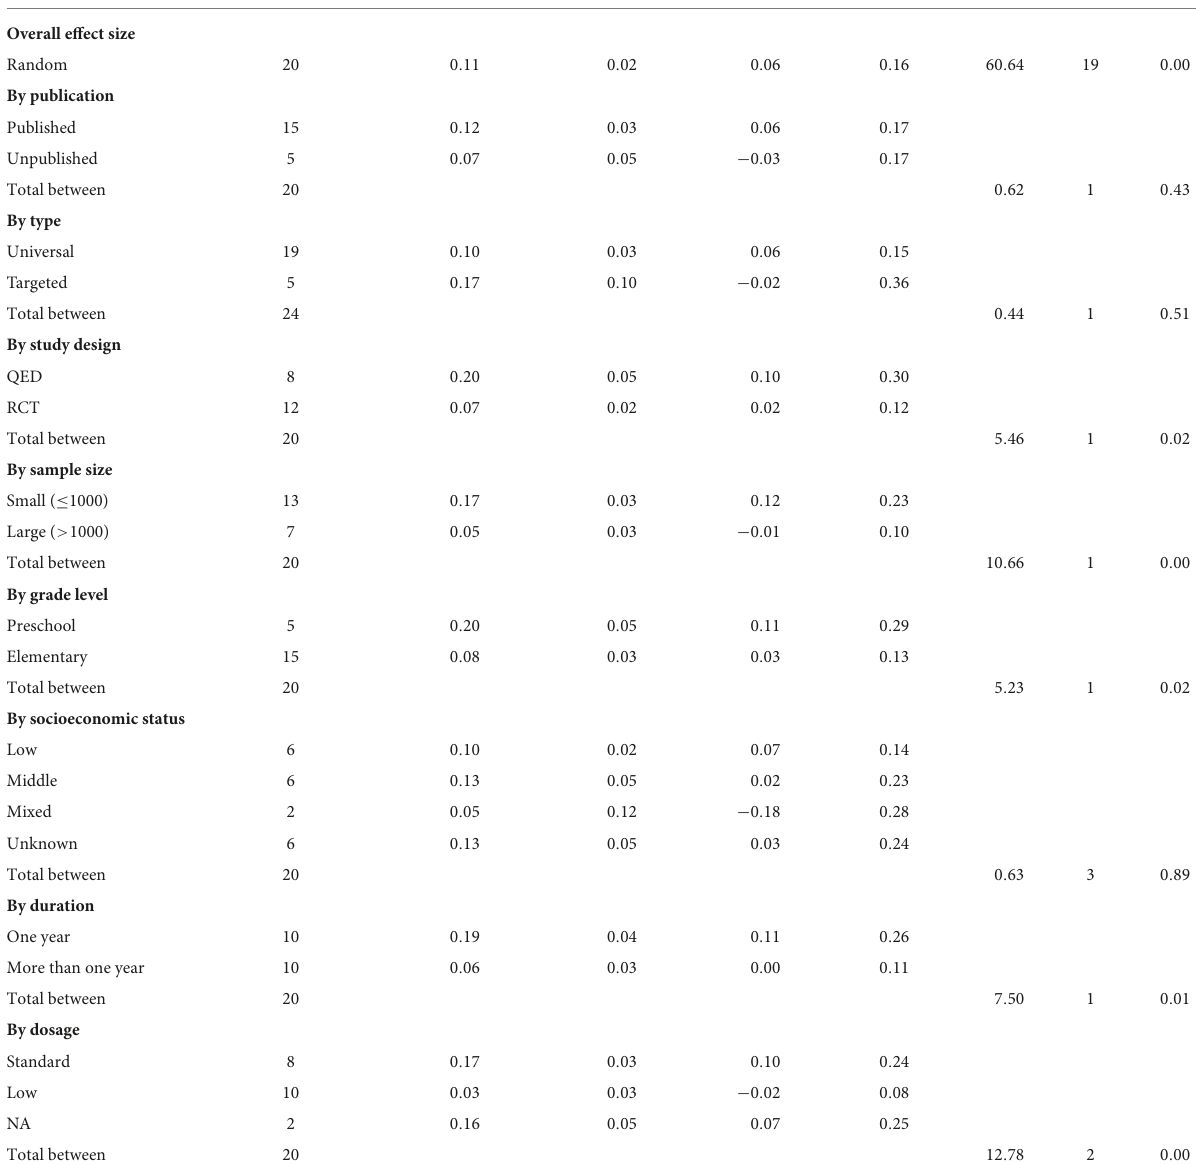
TABLE 3 Subgroup analysis. Study features Effect size and 95% confidence